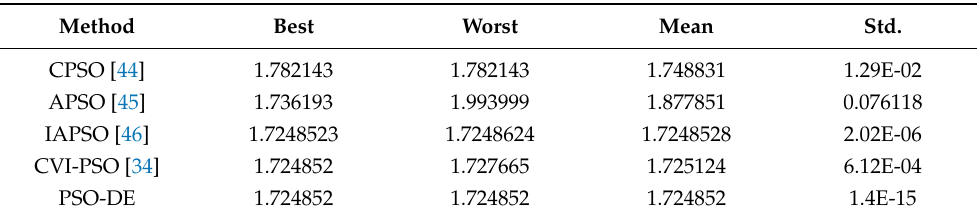
Table 14. Comparison of optimization results of different algorithms for the welding beam problem.